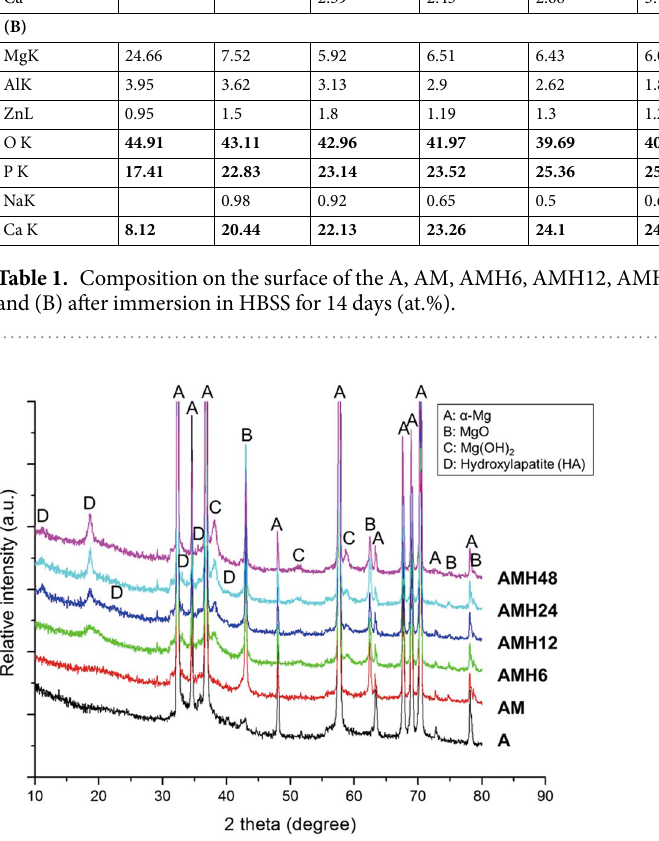
Electrochemical corrosion test. Figure 3 and Table 2 show the results of the potentiodynamic polarization